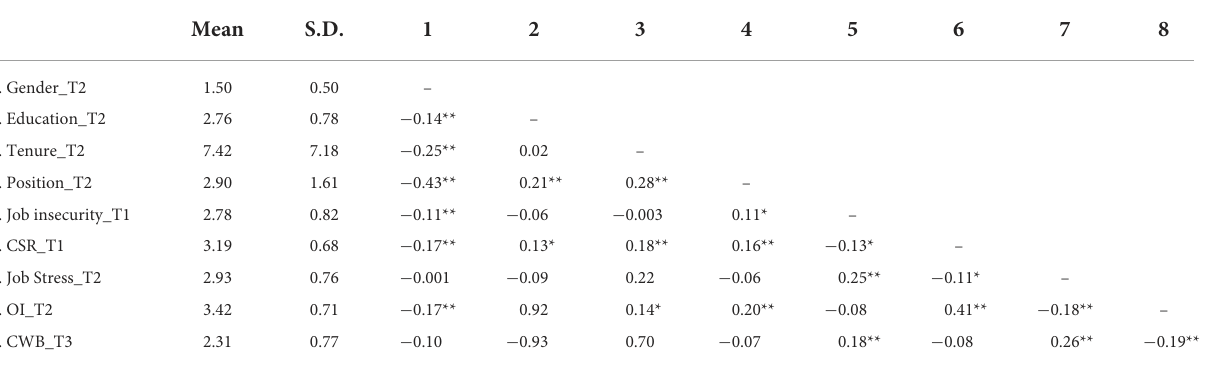
TABLE 2 Correlations among research